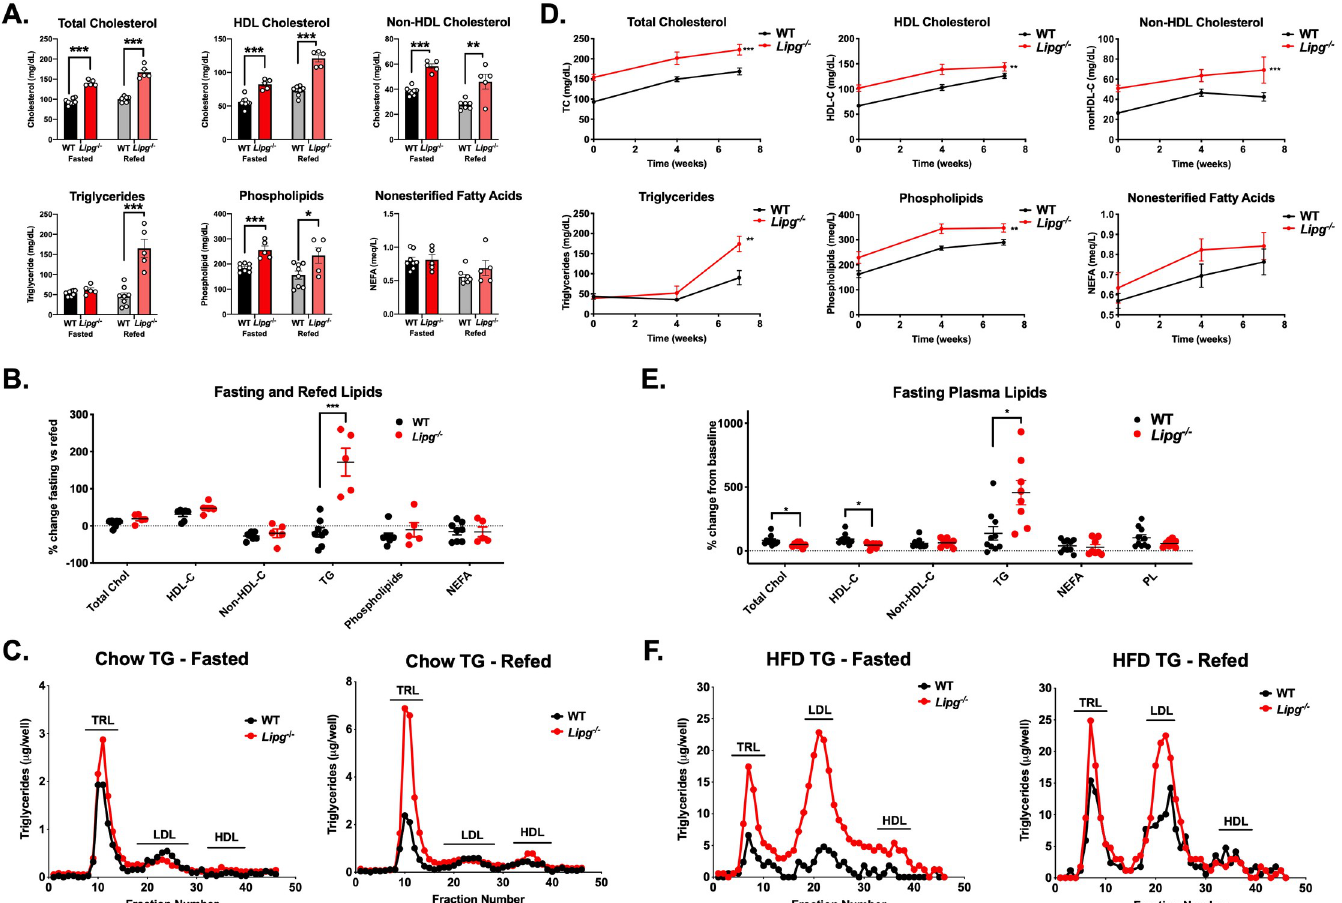
Fig 3. Genetic loss-of-function of Lipg and plasma triglycerides in mice. A. Plasma TC, HDL-C, nonHDL-C, TGs, phospholipids, and nonesterified fatty acids from WT vs. Lipg -/- mice after a 4 hour fast and again after 4 hours of refeeding a chow diet. Lipids were measured by chemical autoanalyzer. B. Percent change in each plasma lipid measure from (A) in 4 hour refed vs fasting measures. C. TG from plasma of fasted mice (left) and four hour-refed mice (right) fractionated by fast-protein liquid chromatography (FPLC) from pools from WT or Lipg -/- mice from groups in (A). D. Total cholesterol, HDL-C, nonHDL-C, TGs, phospholipids, and nonesterified fatty acids in WT and Lipg -/- mice after initiation of feeding adult mice a diet composed of 45% kilocalories fat for the indicated timepoints. Plasma was collected 4 hours after fasting and lipids were measured by autoanalyzer. E. Fasting plasma lipids after 7 weeks of high fat feeding were normalized to the levels at zero weeks of feeding and expressed as a percentage change. F. Triglycerides from fasted (left) and refed (mice) from (D-E) after FPLC-fractionation of plasma. A, B, E: � P < 0.05, �� P < 0.01, ��� P < 0.001, Student’s unpaired T-test. D: �� P < 0.01, ��� P < 0.001, repeated factor 2-way ANOVA compared to WT group. Data is expressed as mean ±